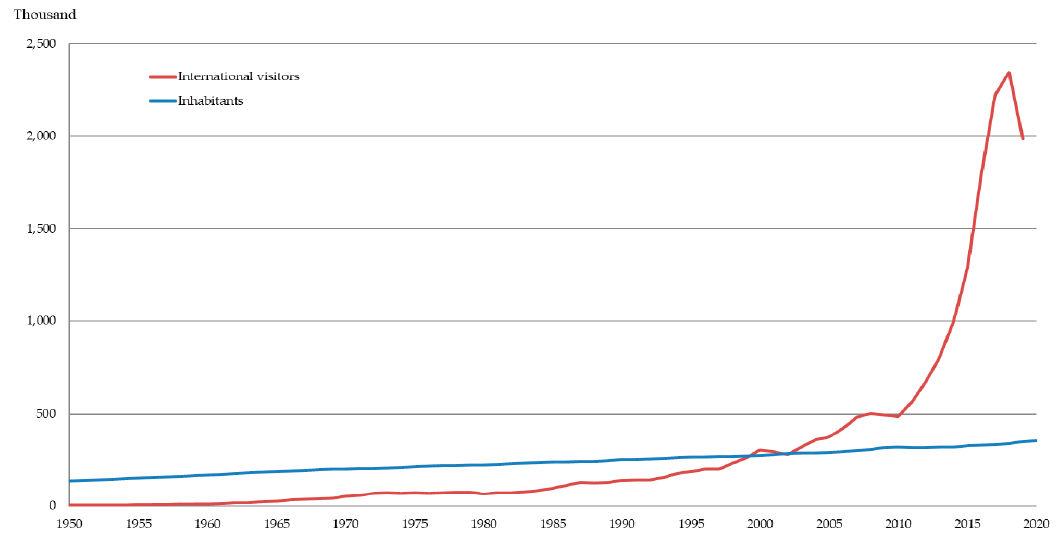
Figure 1. Number of international visitors to Iceland and number of inhabitants in Iceland. Derived from data in: [8,9] .